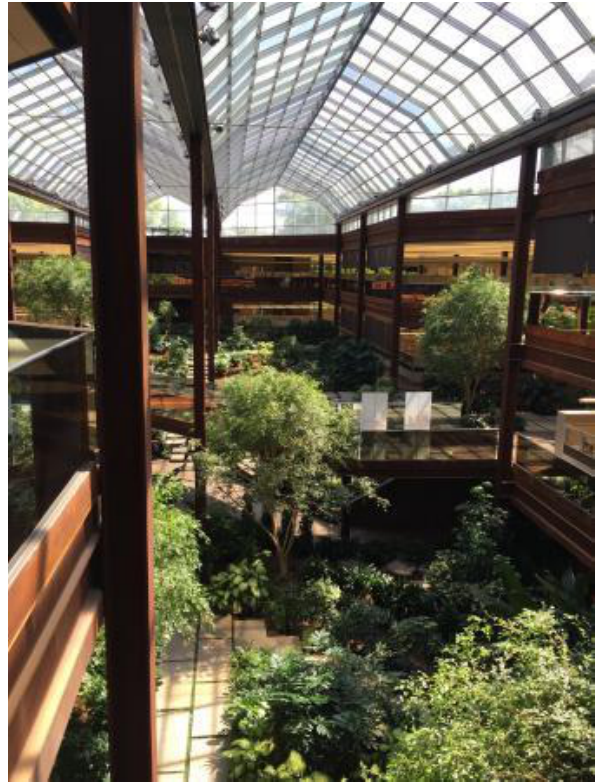
Figure 4. John Deere World Headquarters Moline, Illinois, USA. Object completed in 1964, architects— Eero Saarinen and Kevin Roche [6]. Photo—public domain.